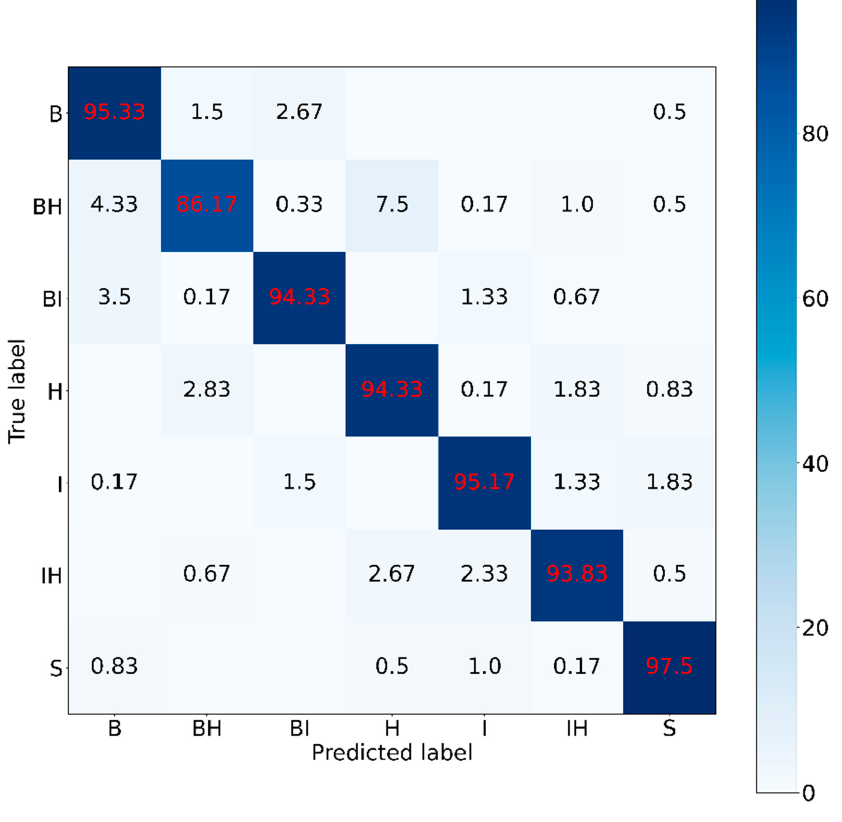
Figure 6. Confusion matrix for DenseNet_BC_34.